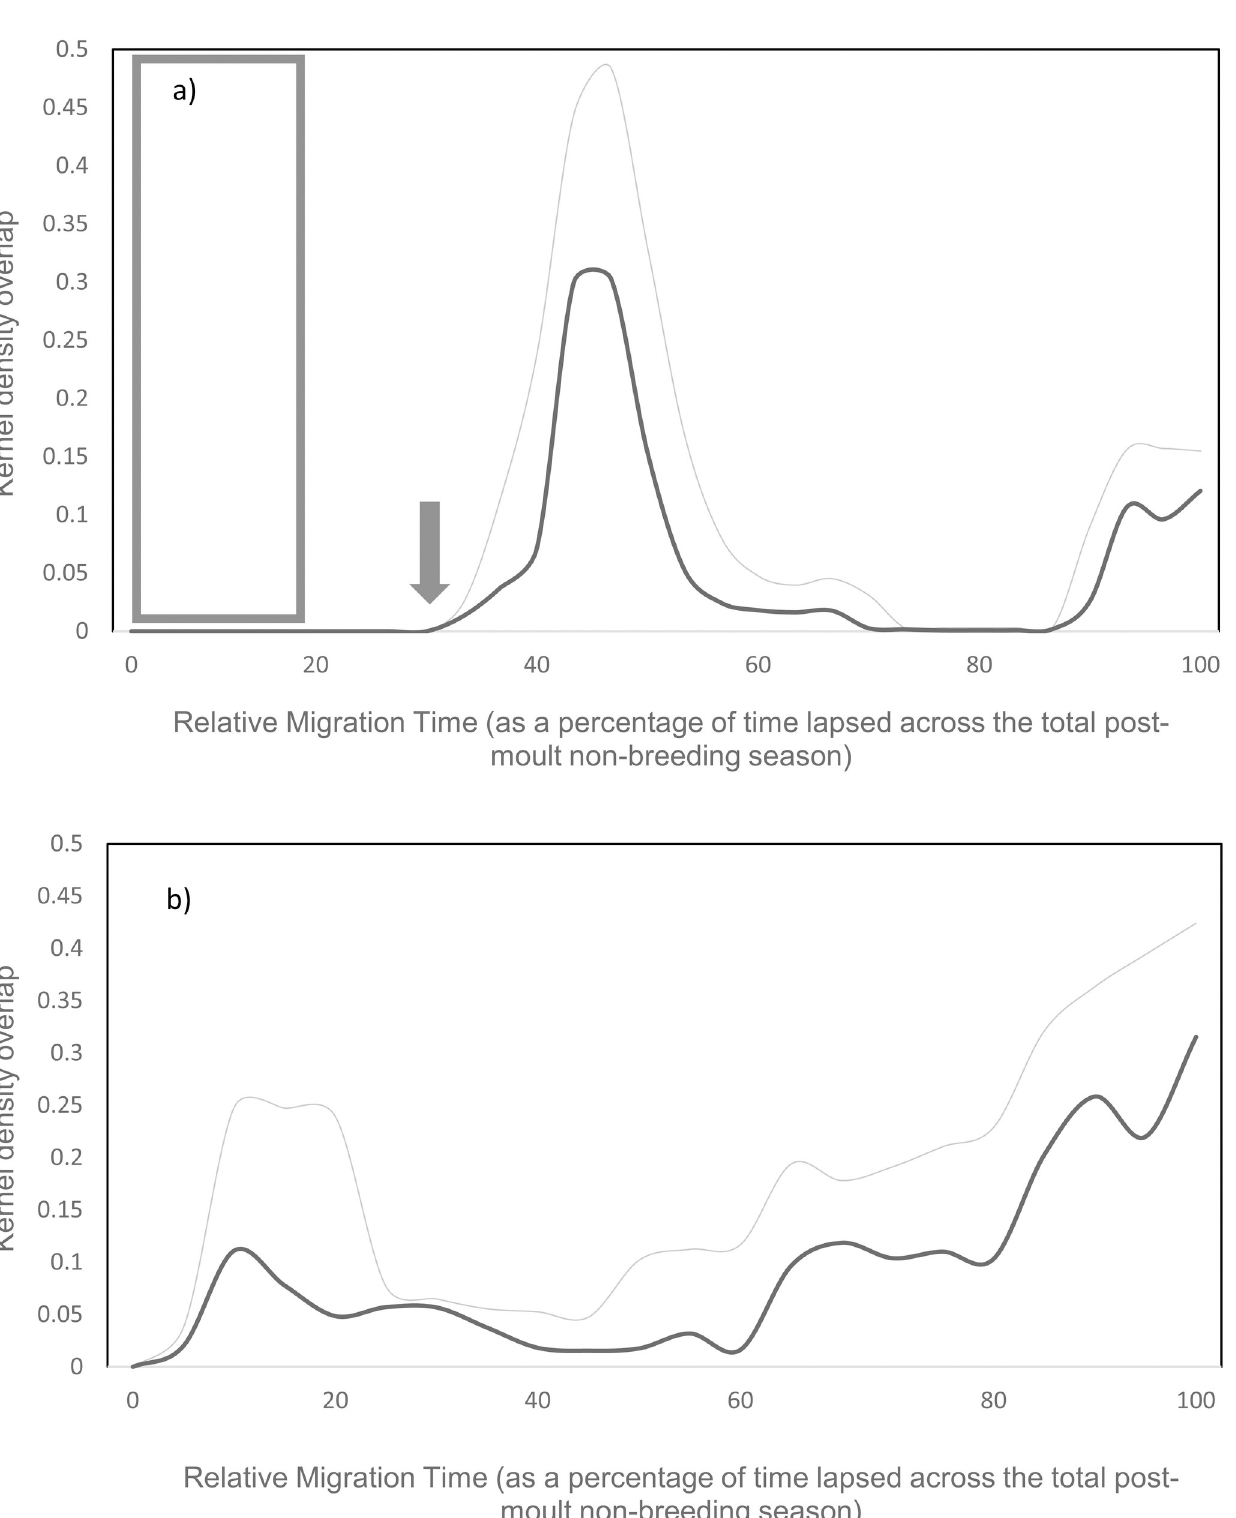
Fig 6. Weekly Utilisation distribution overlapping statistics and area under the curve comparisons between observed and synchronous migrations. Overlap indices for the core area (50% isopleth; dark grey) and the peripheral utilisation distributions (90% isopleth; light grey) for a) the observed and b) the synchronous migrations for Snares and Fiordland penguins during their non-breeding season presented with the relative percentage of time lapsed